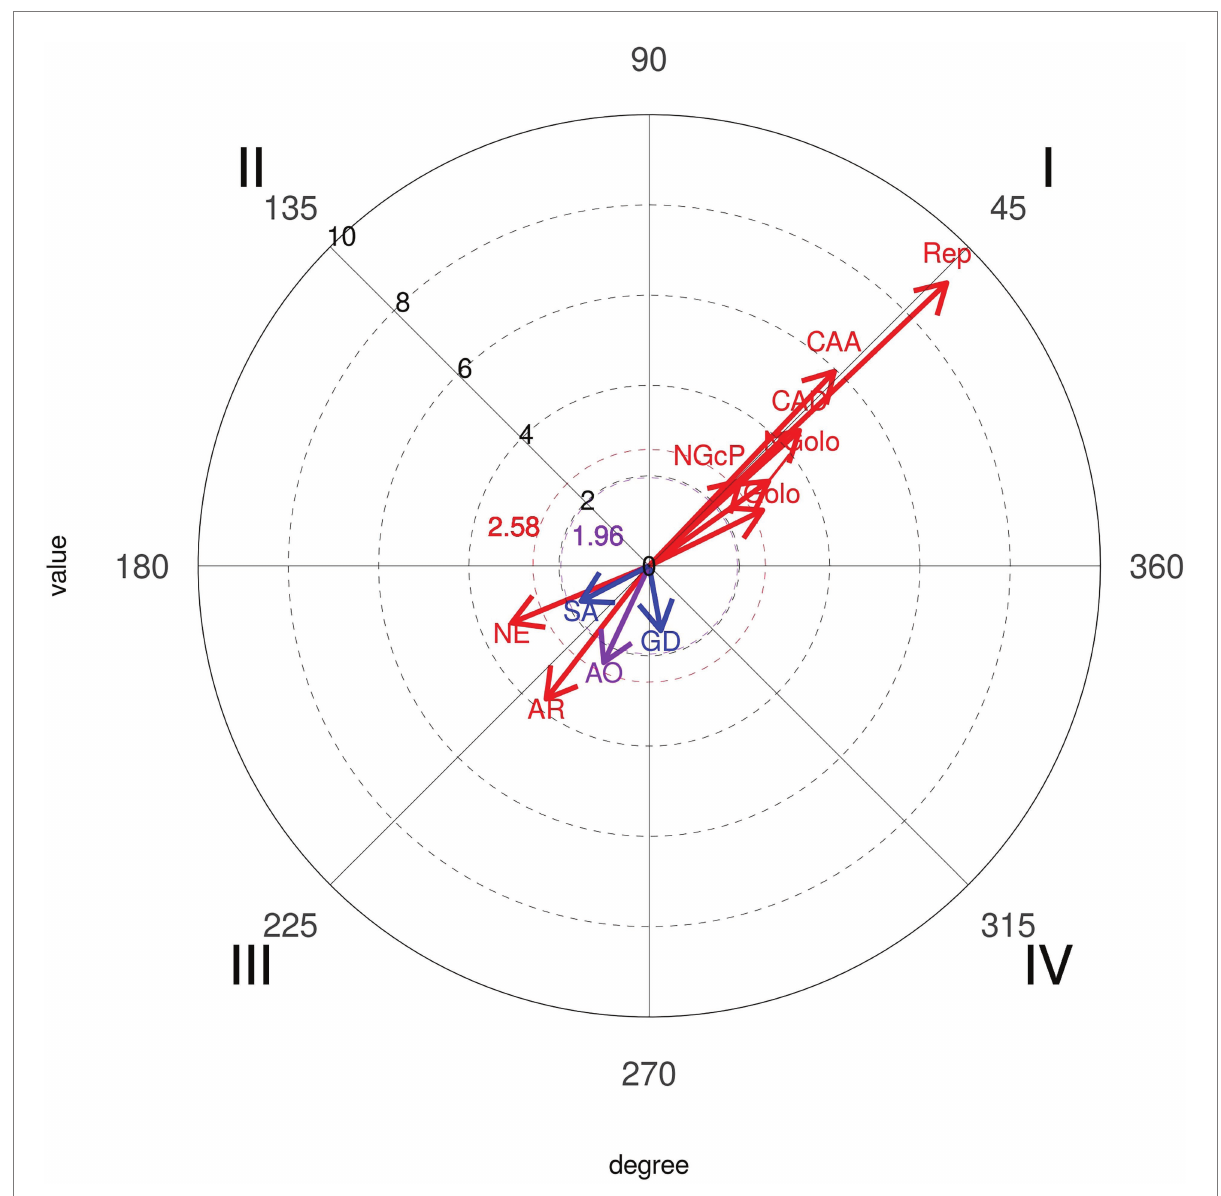
FIGURE 14 Polar coordinate analysis map: focal conduct “Portugal National Team.” Conditioned conducts: Rep, throw-off; AR, fast attack; NE, no response; AO, organized attack; CAD, direct fast break; CAA, sustained fast break; NGolo, opponent no goal; Golo, opponent goal; NGcP, no goal with